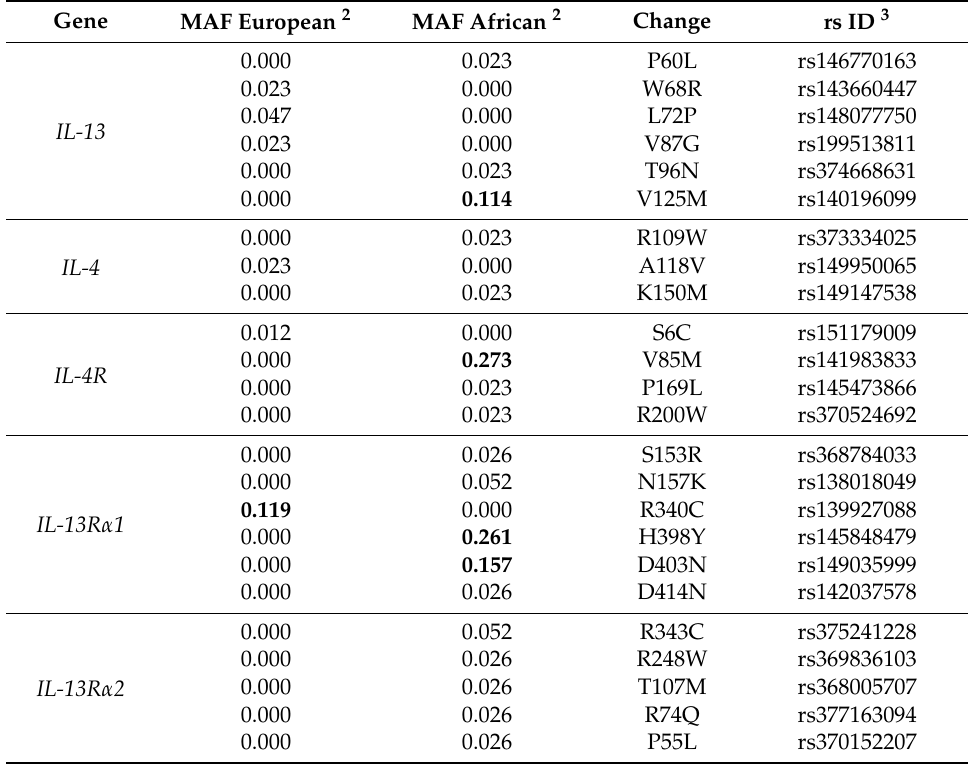
Table 2. Frequencies of damaging variants in key genes affecting IL-13 signaling.